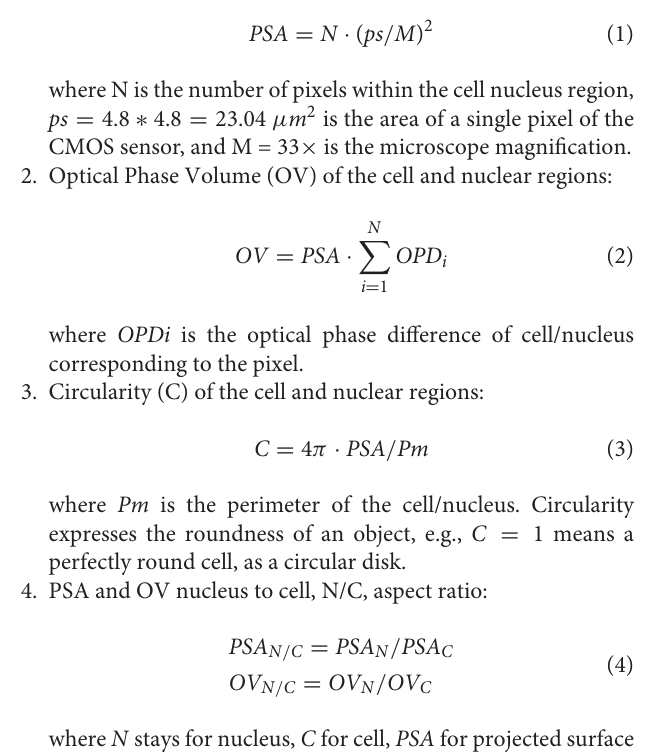
FIGURE 3 | is indicated by blue color. The legend of the parameters is shown top right: PSA N , PSA C —nucleus PSA and cell PSA, respectively; C N , C C —nucleus circularity and cell circularity, respectively; OV N , OV C —nucleus OV and cell OV, respectively; PSA N / C , OV N / C —ratio between the cell and nucleus for PSA and OV; SNG—segmented